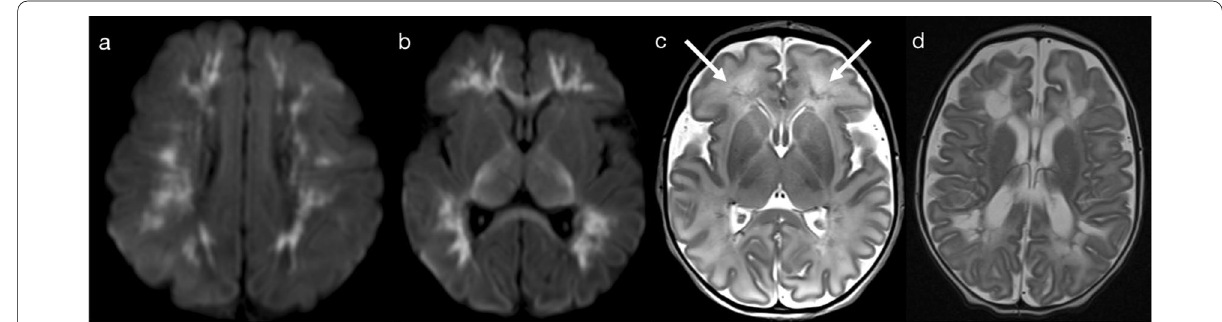
Fig. 2 Restricted diffusion in supratentorial white matter—diffuse (Pattern 1A). 2‑day‑old term infant with generalised seizures and CSF‑proven